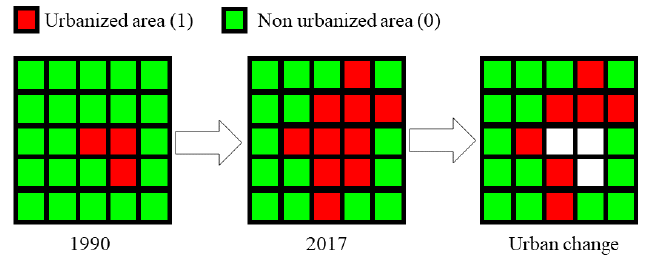
Figure 3. Illustration of urban change degree. The value of 25 pixels are averaged to give the degree (original pixel is 30 m resolution).